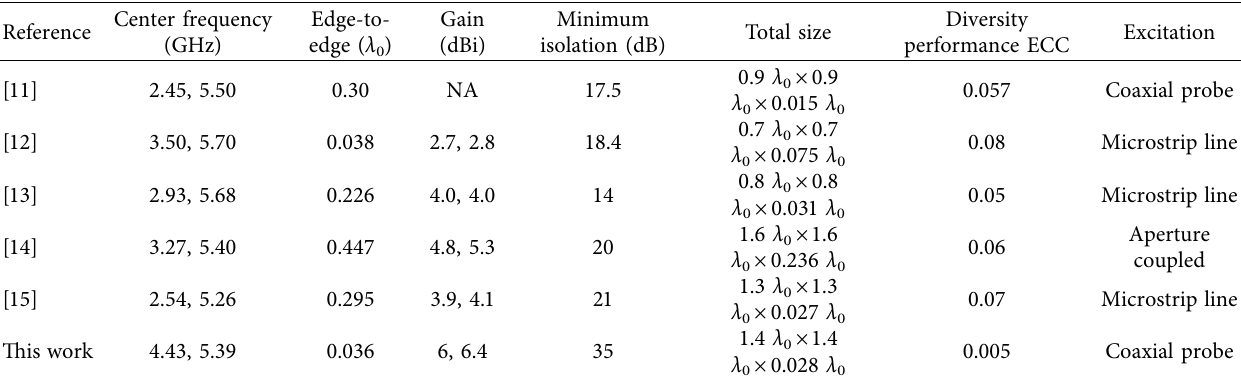
Figure 18: Computed channel capacity loss (CCL) of the proposed MIMO antenna. Table 1: Comparison